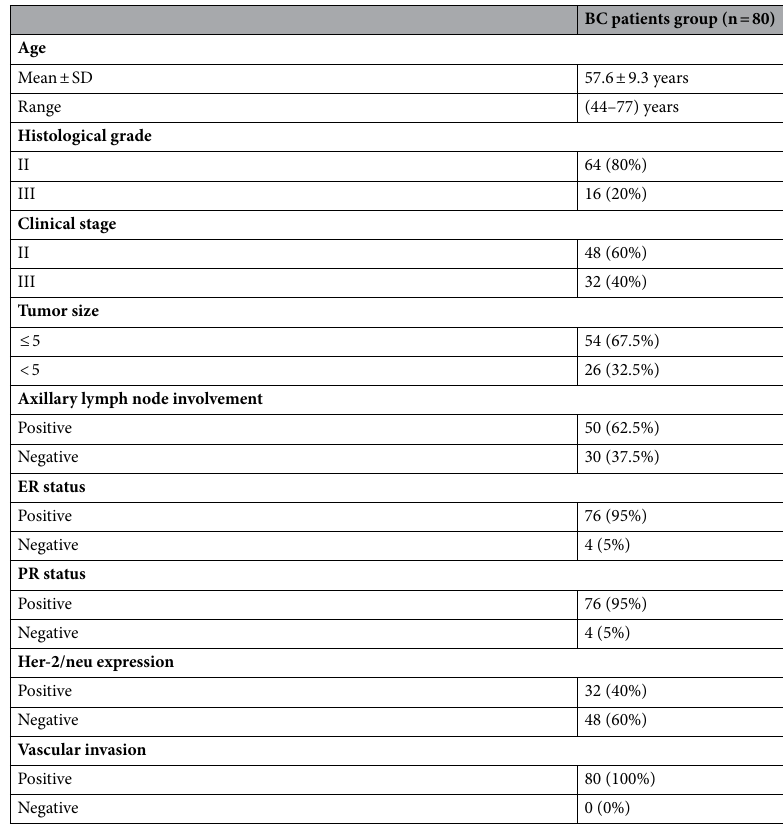
Table 4. Clinicopathological characteristics of BC patients group (n = 80). ER estrogen receptor status, PR progesterone receptor status, Her-2 human epidermal growth factor receptor